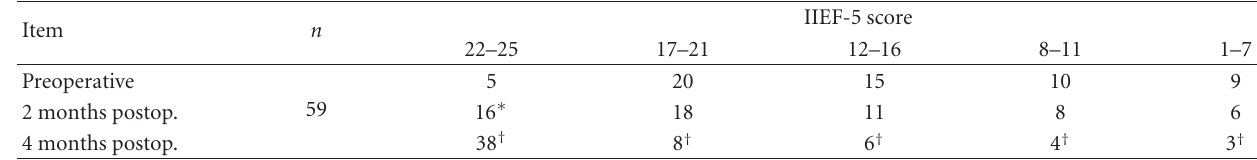
Table 4: IIEF-5 score before and after kidney